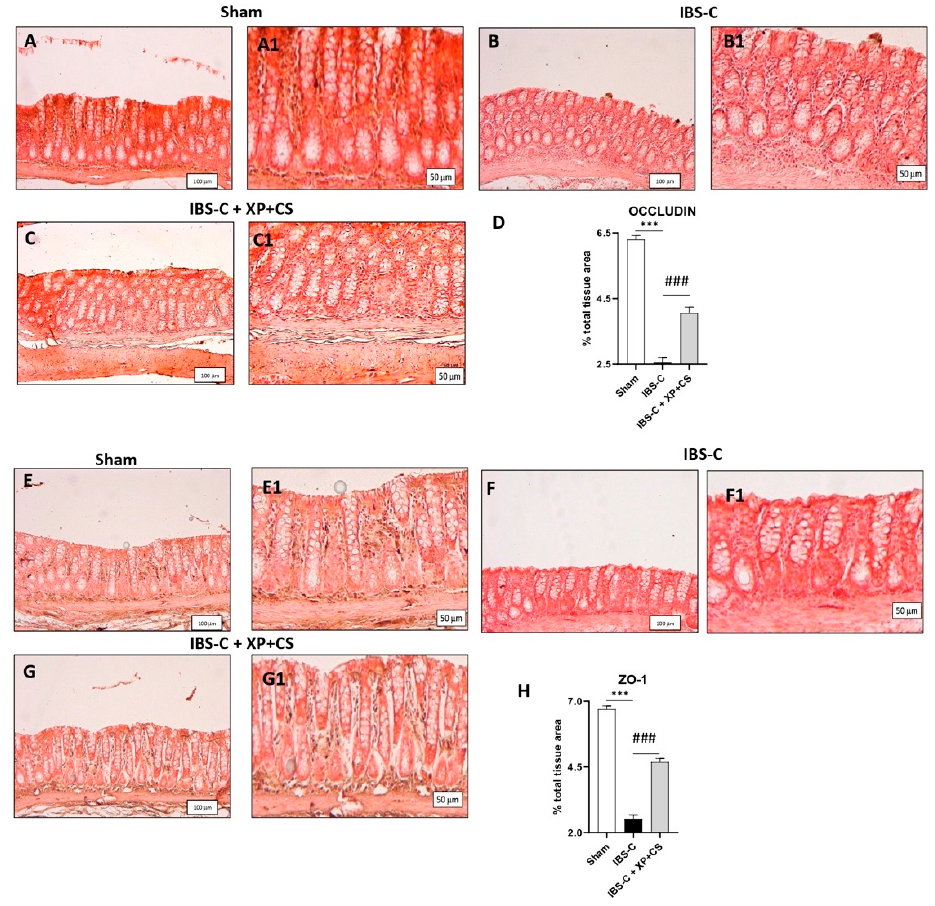
Figure 3. XP and CS treatment restored tight junctions’ expression after IBS constipation. ( A and A1 ) Basal expression of Occludin in the colon of Sham rats (magnification 10x and 20x). ( B and B1 ) Loss of tight junction Occludin immunopositivity in the colon from IBS-C rats (magnification 10x and 20x). ( C and C1 ) XP + CS treatments restored Occludin immunopositivity after IBS-C (magnification 10x and 20x). ( D ) Percentage of Occludin signal/total area. *** p < 0.001 vs. Sham; *** p < 0.001 vs. IBS-C. ( E and E1 ) Basal expression of ZO-1 in the colon of Sham rats (magnification 10x and 20x). ( F and F1 ) Loss of tight junction ZO-1 immunopositivity in the colon from IBS-C rats (magnification 10x and 20x). ( G and G1 ) XP + CS treatments restored ZO-1 immunopositivity after IBS-C (magnification 10x and 20x). ( H ) Percentage of ZO-1 signal/total area. *** p < 0.001 vs. Sham; ### p < 0.001 vs. IBS-C.